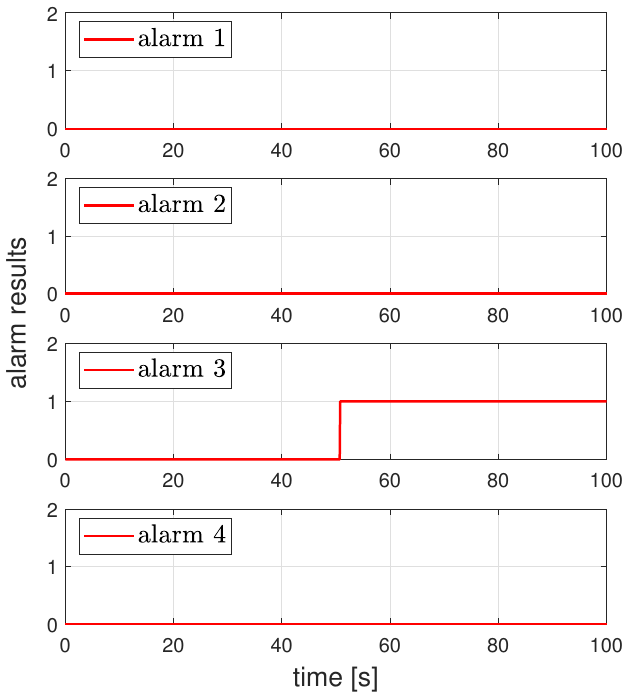
Figure 5. Actuator fault detection result for the circle tracking case. A value of one indicates an actuator fault and the value of zero indicates normal operation.